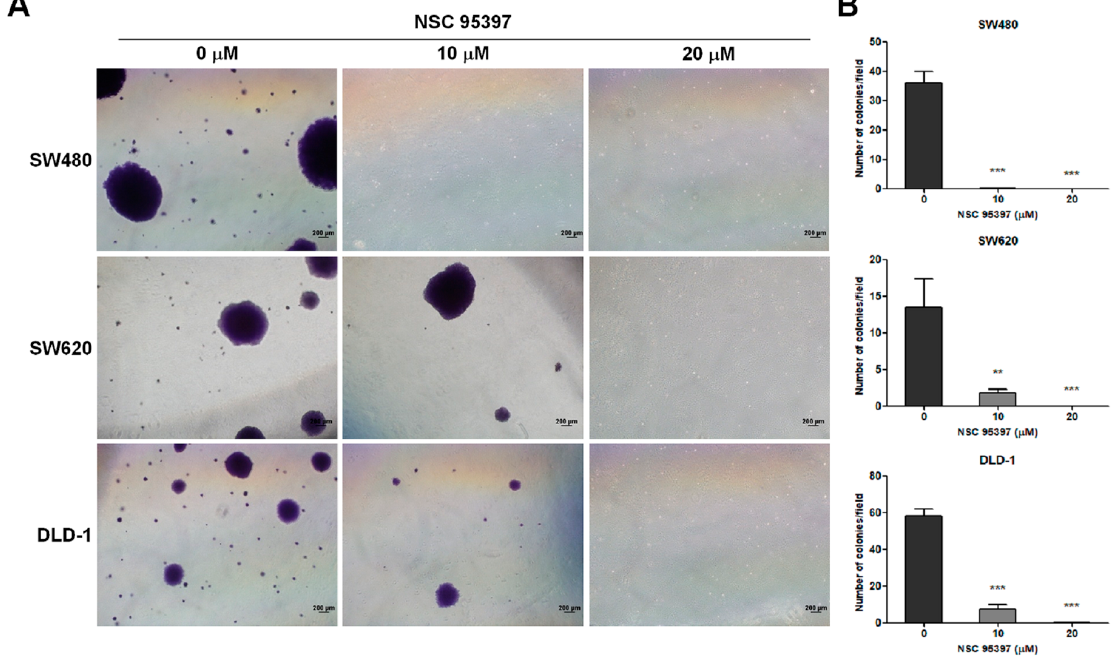
Figure 2. NSC 95397 reduces anchorage independent growth of human colon cancer cells. ( A ) Representative phase-contrast images and ( B ) quantitation of colony formed by SW480, SW620, and DLD-1 cells treated with indicated concentrations of NSC 95397; scale bars indicate 200 µm. Values are means + SD; ** p < 0.01; and *** p < 0.001 using one-way analysis of variance (ANOVA), compared to vehicle control (0 µM).